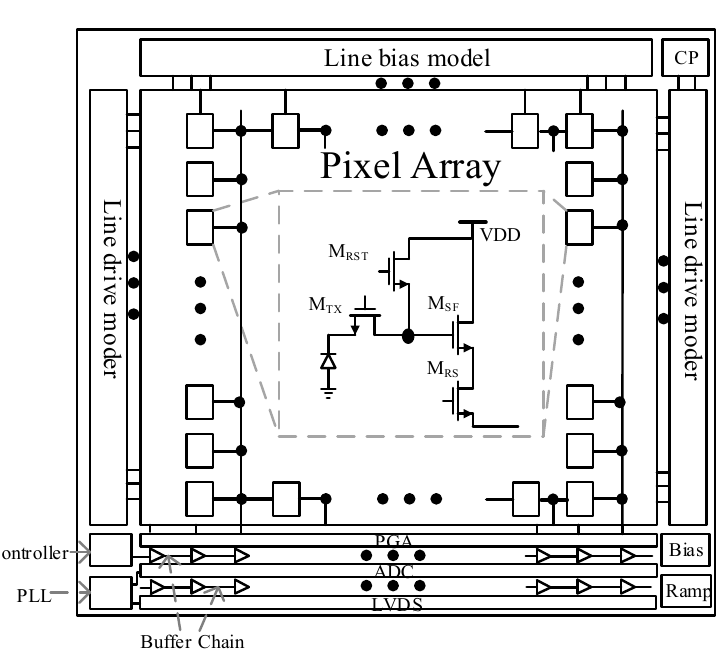
Figure 1. Schematic diagram of the CIS system framework.